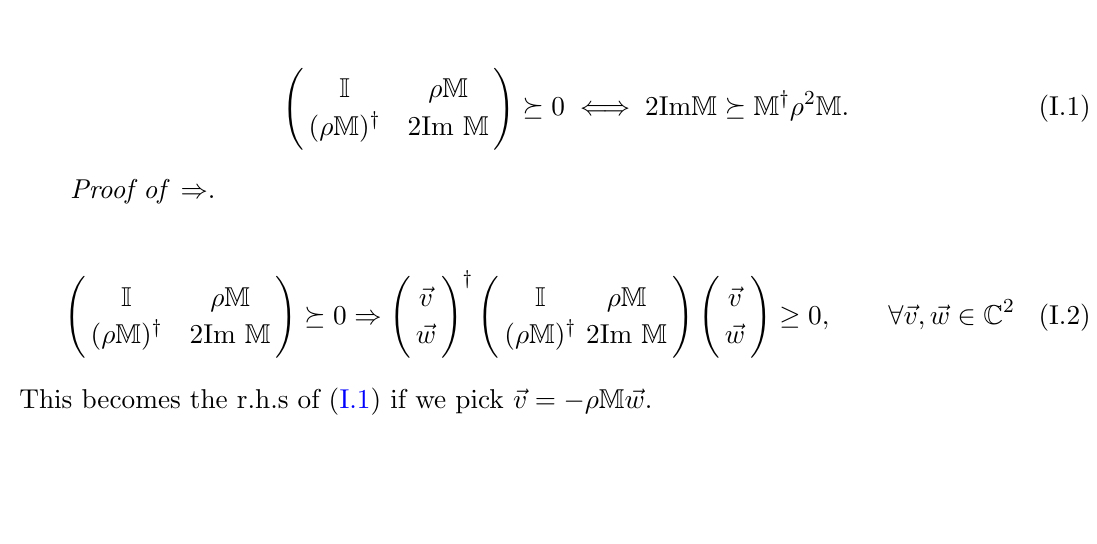
12 j (cid:20) 1 and !